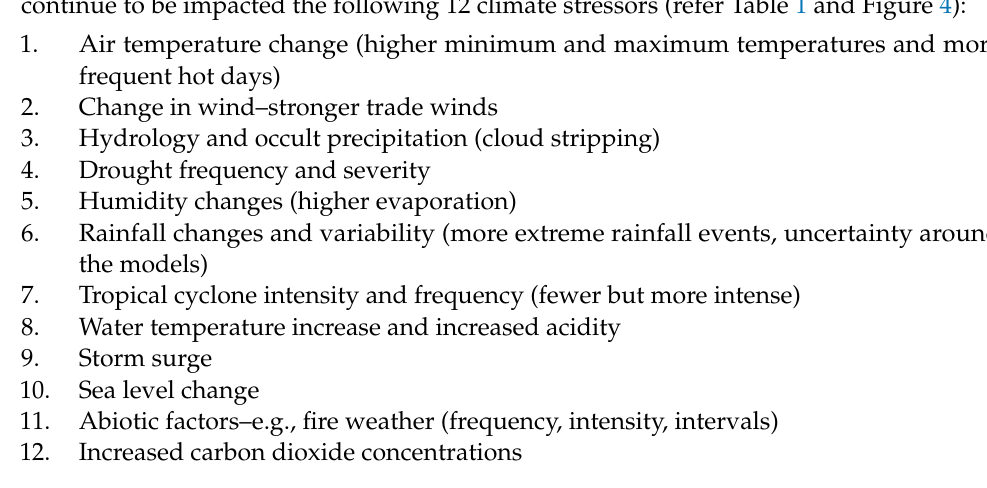
Table 1. An assessment of the World Heritage attribute that contributes to the Outstanding Universal Value of the Wet Tropics, and if climate change will impact on that criteria (data source: Wet Tropics Management Authority Scientific Advisory